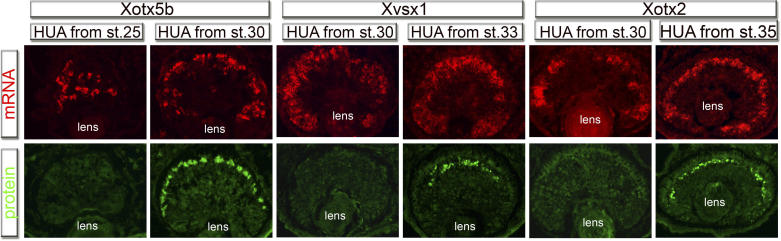
Blocking Cell Cycle by HUA Inhibits the Sequential Translation of Xotx5b, Xvsx1, and Xotx2 mRNAsIn situ hybridization (mRNA: Fast Red detection) and antibody immunodetection (protein: green fluorescence) on 10-μm thick serial sections of st. 42 retinas. Embryos were grown in medium containing HUA (hydroxyurea, 150 μM and aphidicolin, 20 μM) from the stage indicated to st. 42. The examples show typical results obtained in three different experiments (n > 15 embryos/treatment in each experiment).